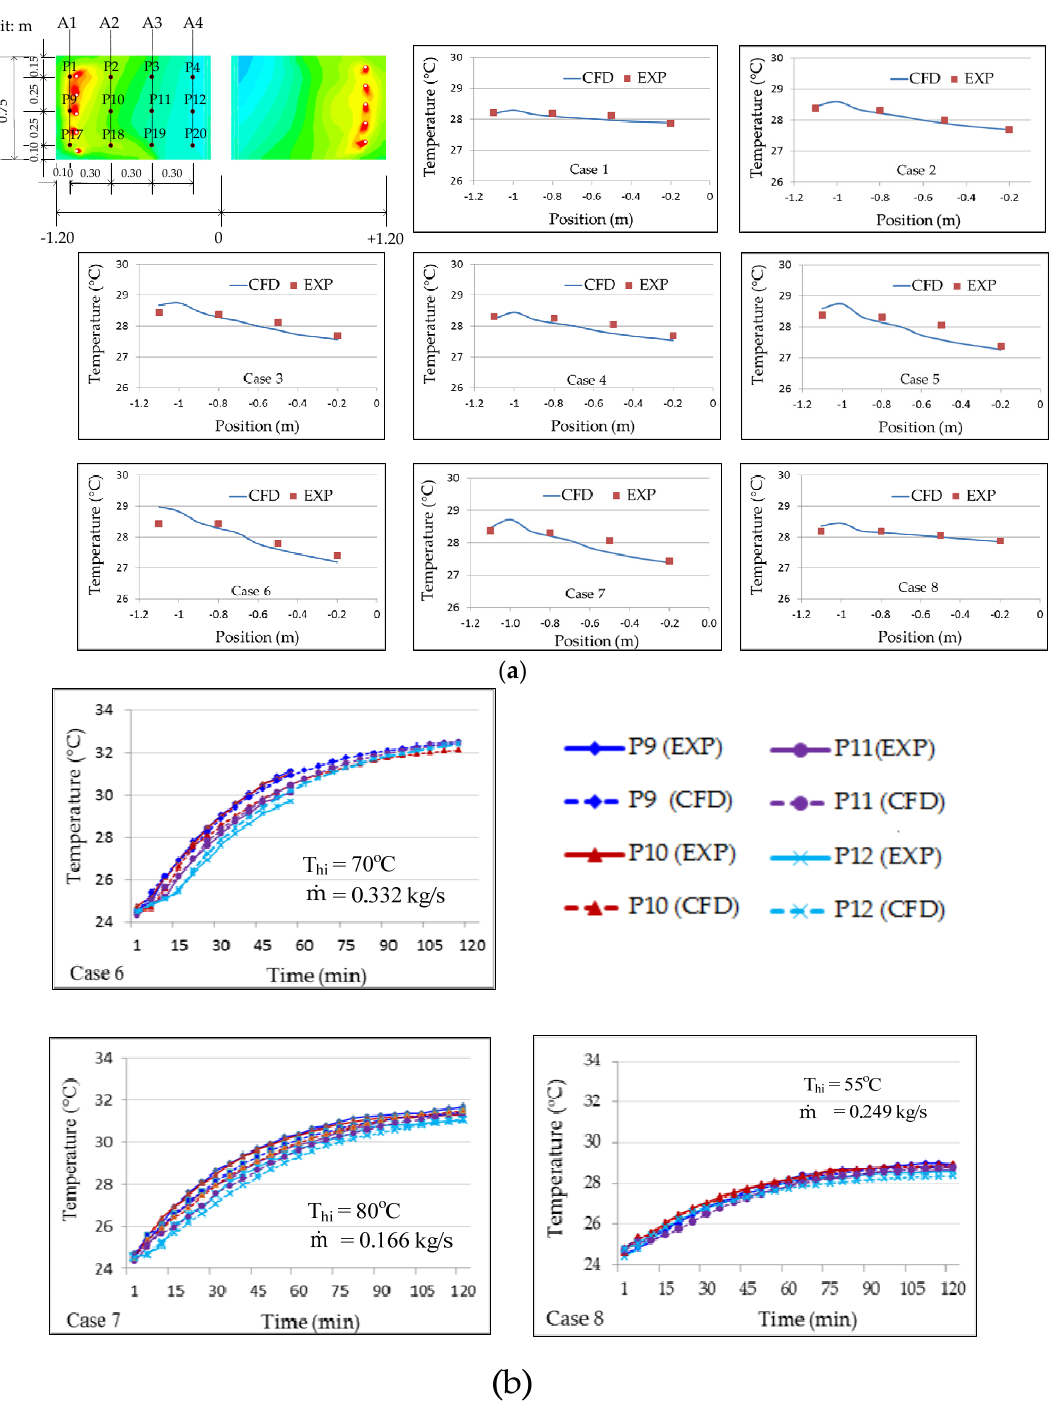
Figure 12. Comparison of temperatures from the CFD and experimental results. ( a ) Temperature distribution of the water in the tank for cases 1–8. ( b ) Temperature measurement results of test points P9–12 during the heat transfer process for cases 6–8.